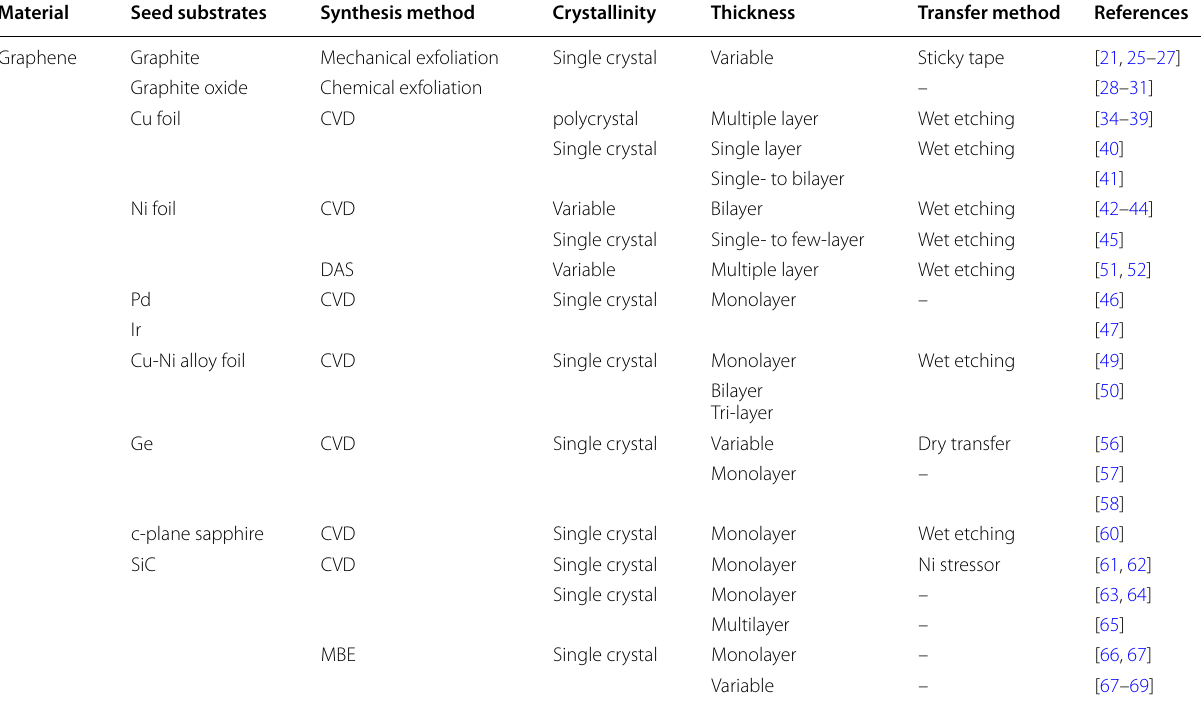
Table 1 Various synthesis and transfer methods of graphene